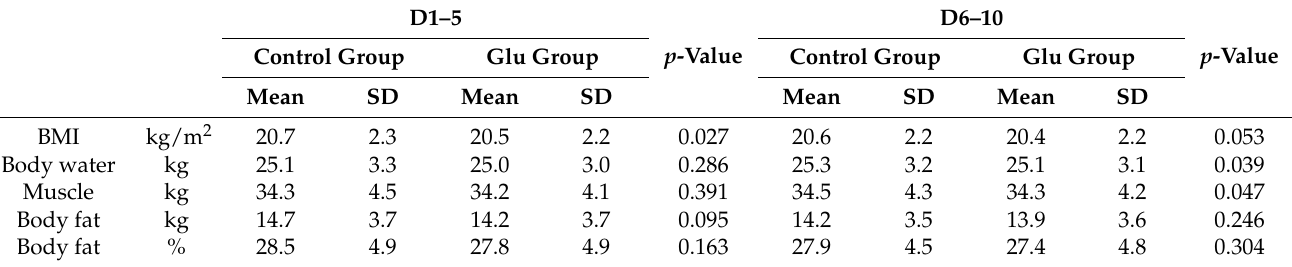
Table 4. Anthropometric measurements during the sodium-restricted